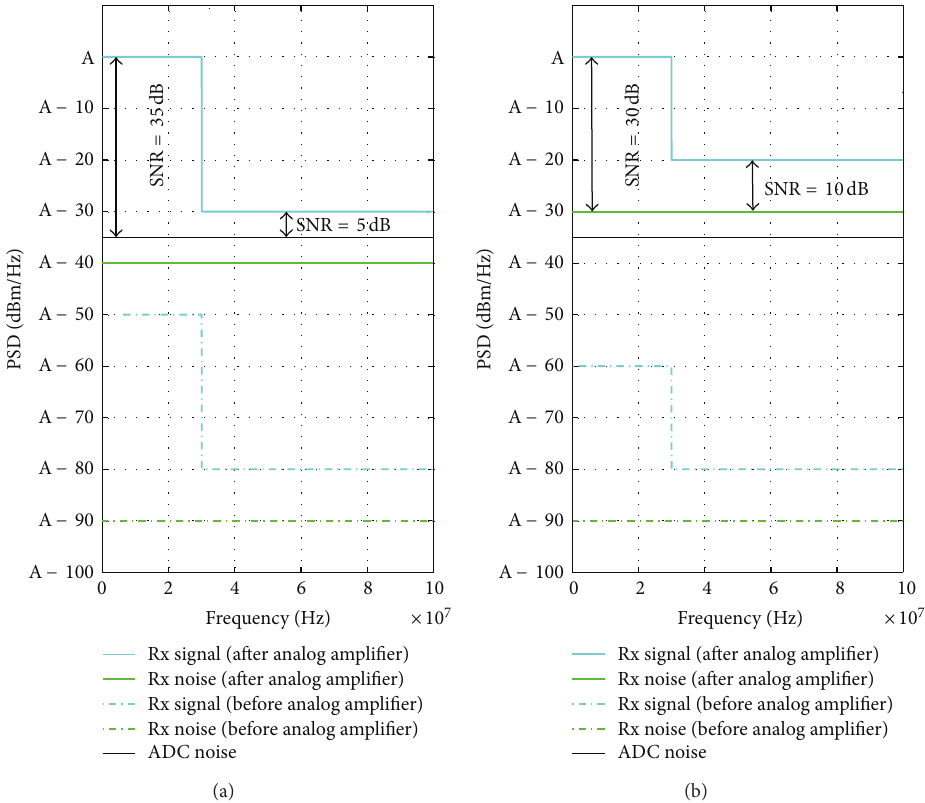
Figure 14: Benefits of power back-off. (a) No power back-off, (b) 10dB power